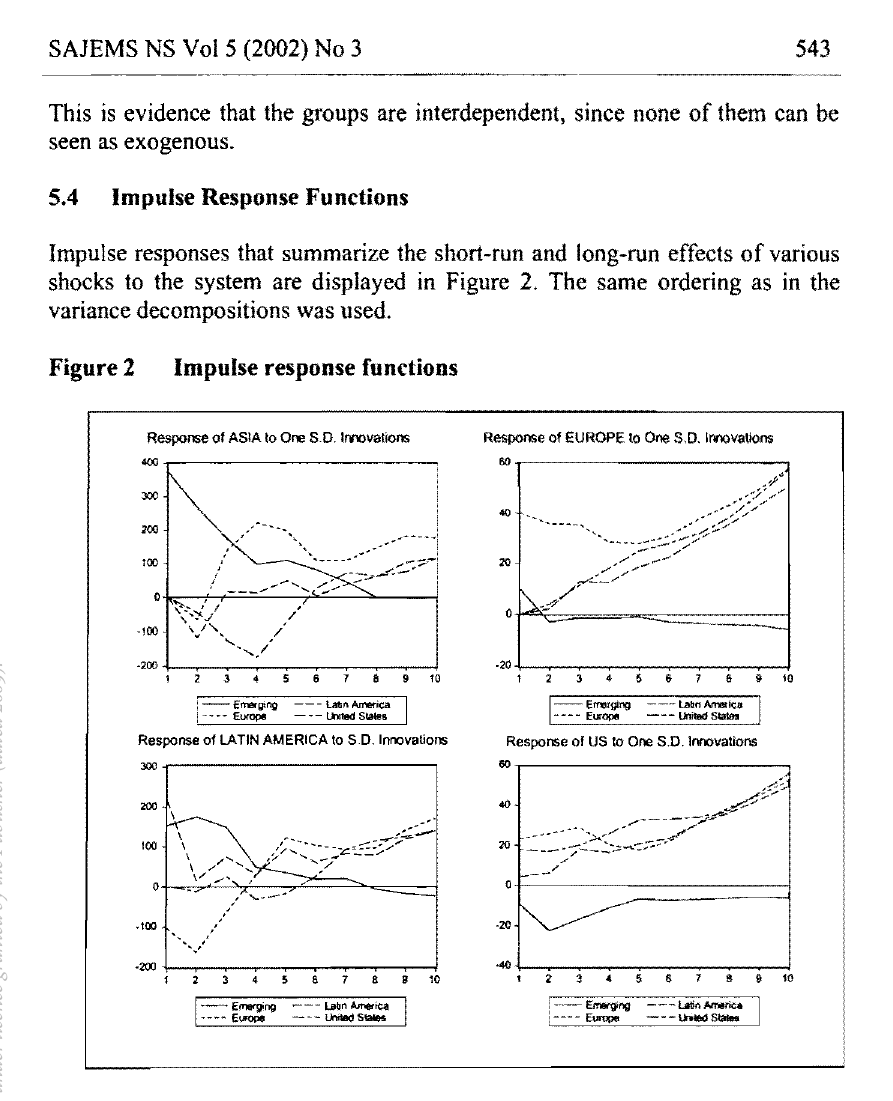
Impulse response functions Response of ASIA to One S.D. Innovations Response of EUROPE to One S.D.